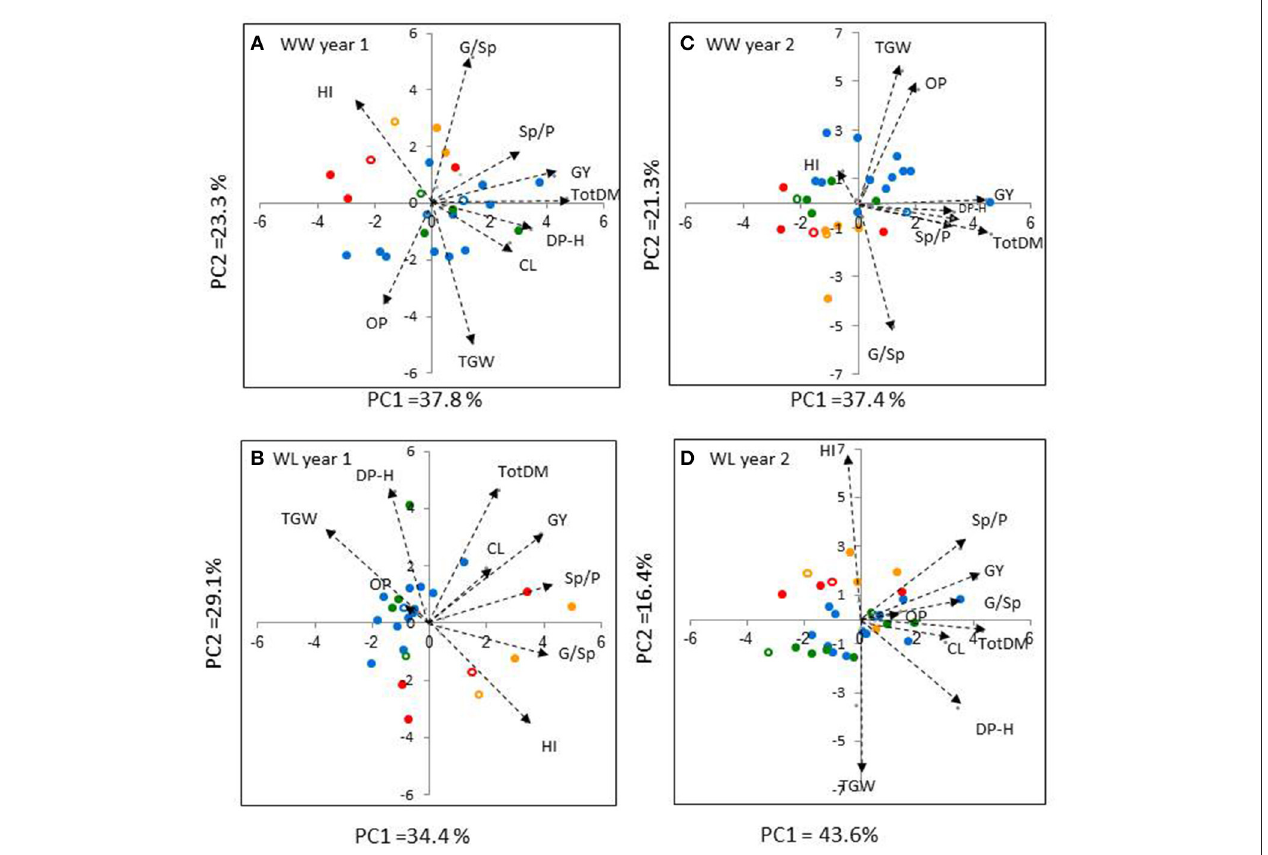
FIGURE 4 | Principal component analysis (PCA) based on correlation matrix of traits: (TotDM), total dry matter; (GY), grain yield; (HI), harvest index; (Sp/P), spikes per plant; (G/Sp), grains per spike; (TGW), thousand grain weight; (DP–H), days from planting to heading; (CL), culm length; fertile spikes per plant, (OP), osmotic potential; recorded on 25 and 32 genotypes in Year 1 (A,B) and Year 2 (C,D), respectively, under well-watered (WW), and water-limited (WL) irrigation regimes. Biplot vectors are trait factor loadings for PC1 and PC2. Each of the recurrent cultivar groups is colored differently (cv. Inbar–blue, cv. Uzan–green, cv. Bar Nir–orange, cv. Zahir–red). Recurrent cultivars are indicated by open